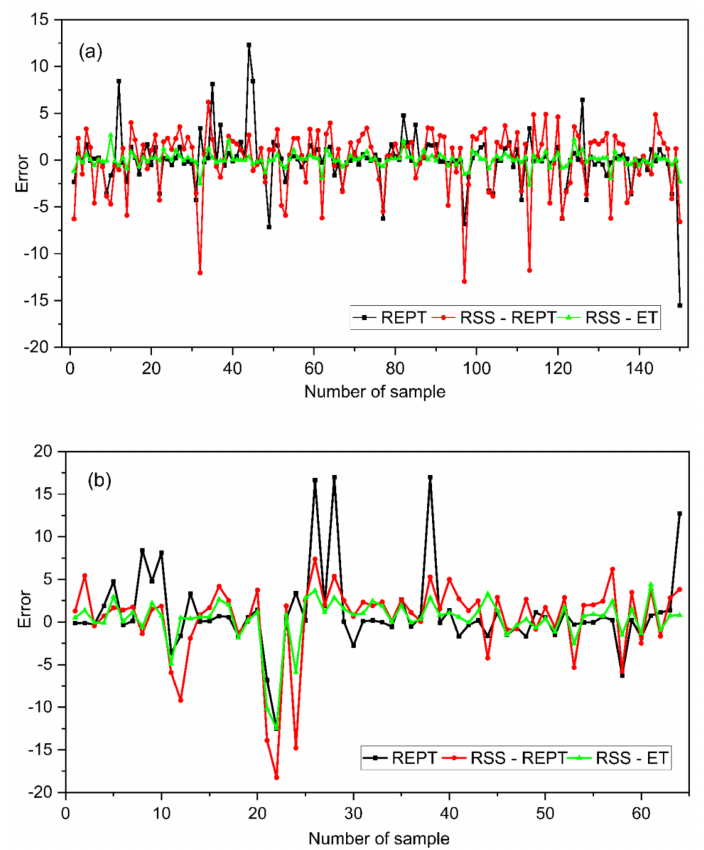
Figure 6. Error values for ( a ) training and ( b )